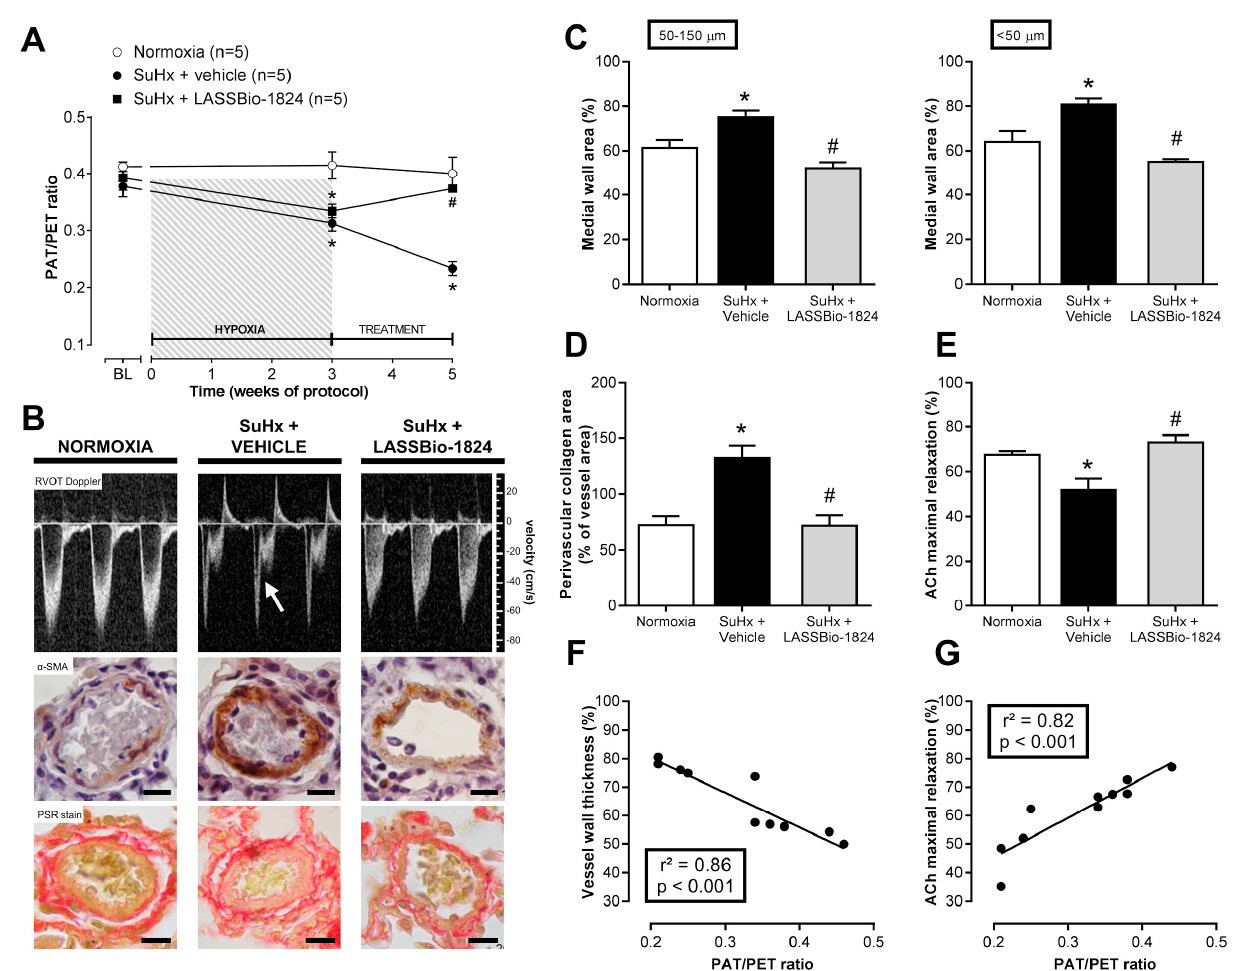
Figure 2. Effect of LASSBio-1824 on pulmonary vascular resistance and remodeling in SuHx. ( A ) Time course of pulmonary vascular resistance development after model induction and treatments ( n = 5 rats per group). ( B ) Representative images of RVOT Doppler TTE, α -SMA immunostain and PSR stain of lung vessels. Arrow depicts a mid-systolic notch in pulmonary flux profile. Bars represent 20 µ m. ( C ), Medial wall hypertrophy of lung vessels ( n = 5 rats per group). ( D ) Perivascular fibrosis around lung vessels ( n = 5 rats per group). ( E ) Maximal ACh-induced relaxation of pulmonary arteries ( n = 5 rats per group). ( F ) Correlation analysis between endpoint pulmonary vascular resistance and wall hypertrophy. ( G ) Correlation analysis between endpoint pulmonary vascular resistance and endothelial function. ACh, acetylcholine; PAT, pulmonary acceleration time; PET, total ejection time; PSR, picro-Sirius red; RVOT, right-ventricle outflow tract; SMA, smooth-muscle actin; TTE, transthoracic echocardiography. * p < 0.05 compared to normoxia. # p < 0.05 compared to SuHx + Vehicle. Table 1. Body morphometry and vascular hemodynamics.